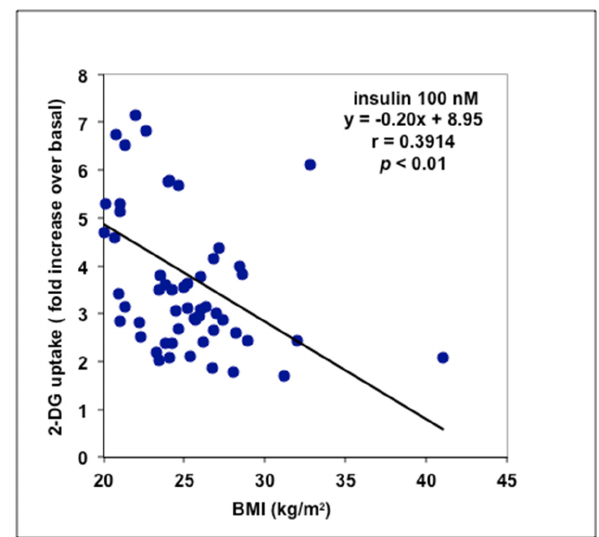
Figure 2. Relationships between obesity (assessed as the body mass index, BMI) and insulin stimulation of glucose transport in adipocytes freshly isolated from abdominal ScAT. Effect of 100 nM insulin is expressed for each individual as fold increase over basal hexose uptake. Linear regression equation and p value refer to 56 individuals, characterized by a mean value for baseline 2-DG uptake of 0.55 ± 0.03 nmol/100 mg lipids/10 min.